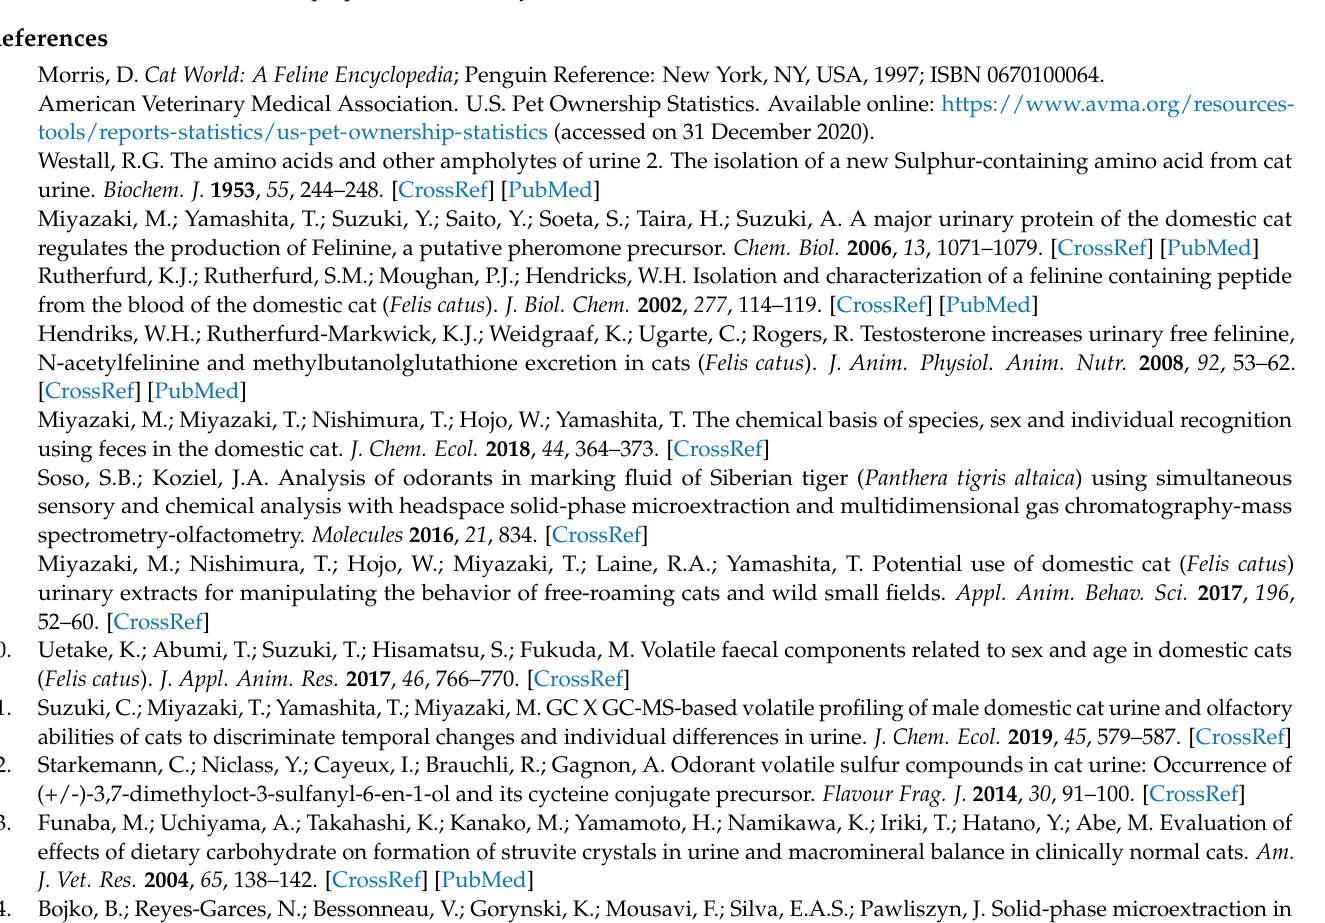
Figure A1. Schematic representation of the cat urine, feces, and soiled litter sample preparation and analysis.